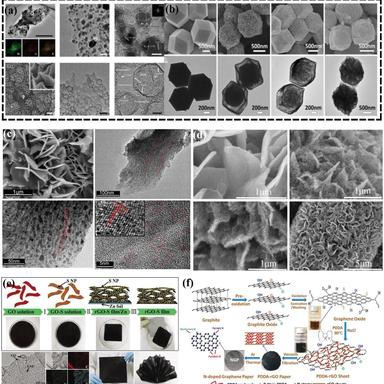
(a) Morphology and structure of HGNs: TEM and corresponding energy dispersive spectroscopy (EDS) mapping of elemental Ni, C, and S and high-resolution (HR-TEM) images of Ni/Ni3-xS2@C; SEM, high magnification of SEM, TEM, and HR-TEM images of HGNs Copyright 2014,American Chemical Society; (b) SEM and TEM images of ZIF-67, single-shelled ZIF-67@LDH, double-shelled CH@LDH nanocages, and CH@LDH/S Copyright 2016, Wiley-VCH; (c) Characterization of vertically aligned S-G arrays